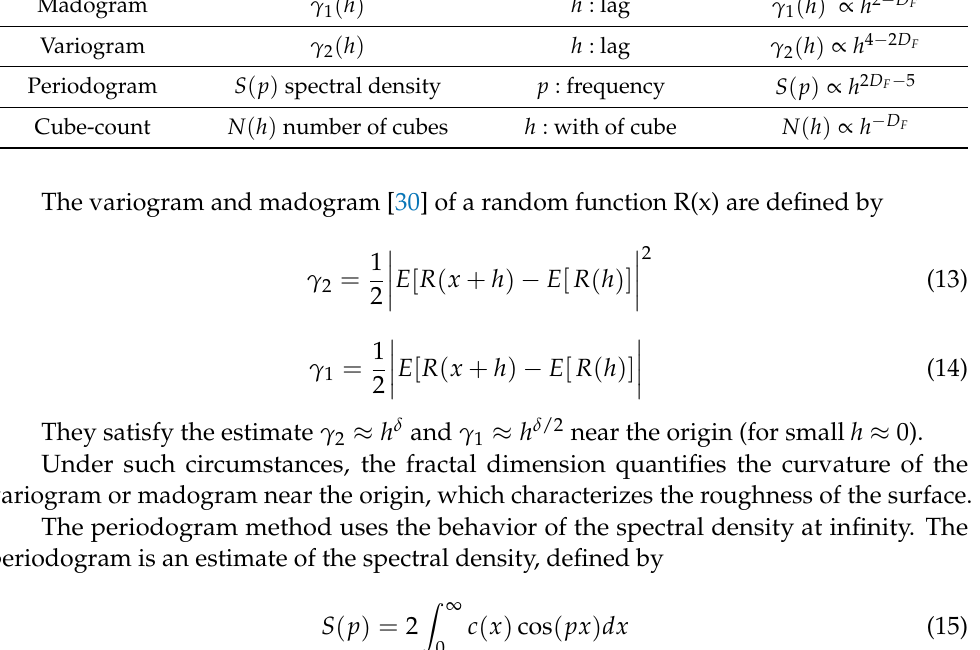
Table 1. Methods considered to estimate the D F of a 1-D rough curve.